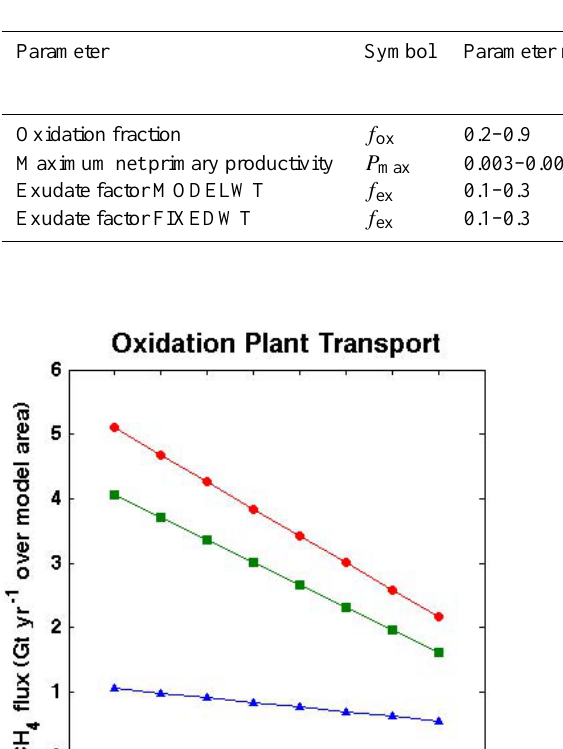
Table 4. Experimental results for parameter with a linear relation between parameter value and model output: oxidation fraction ( f ox ), vegetation net primary production (NPP, parameter symbol P max ), and root exudation rate ( f ex ). The numbers in the last three columns contain the modelled flux (GtCH 4 yr − 1 ) at lower end of the modelled parameter range and the percentage increase (+) or decrease ( − ) at the higher end.